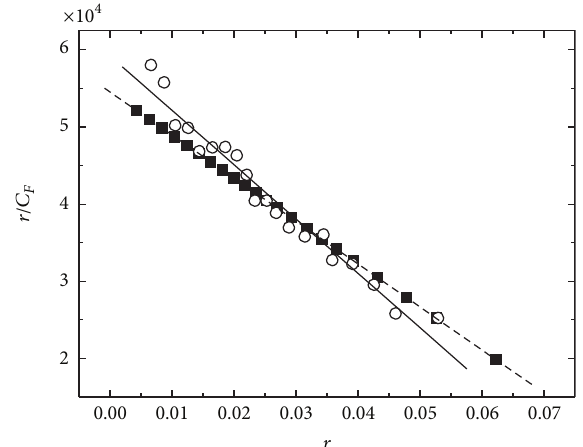
Figure 7: (a) Absorbance spectra recalculated using A where F is given by the fitted model. (b) The residual absorbance − A ) of the difference between the recalculated and spectra ( A Fit Exp experimental spectra.